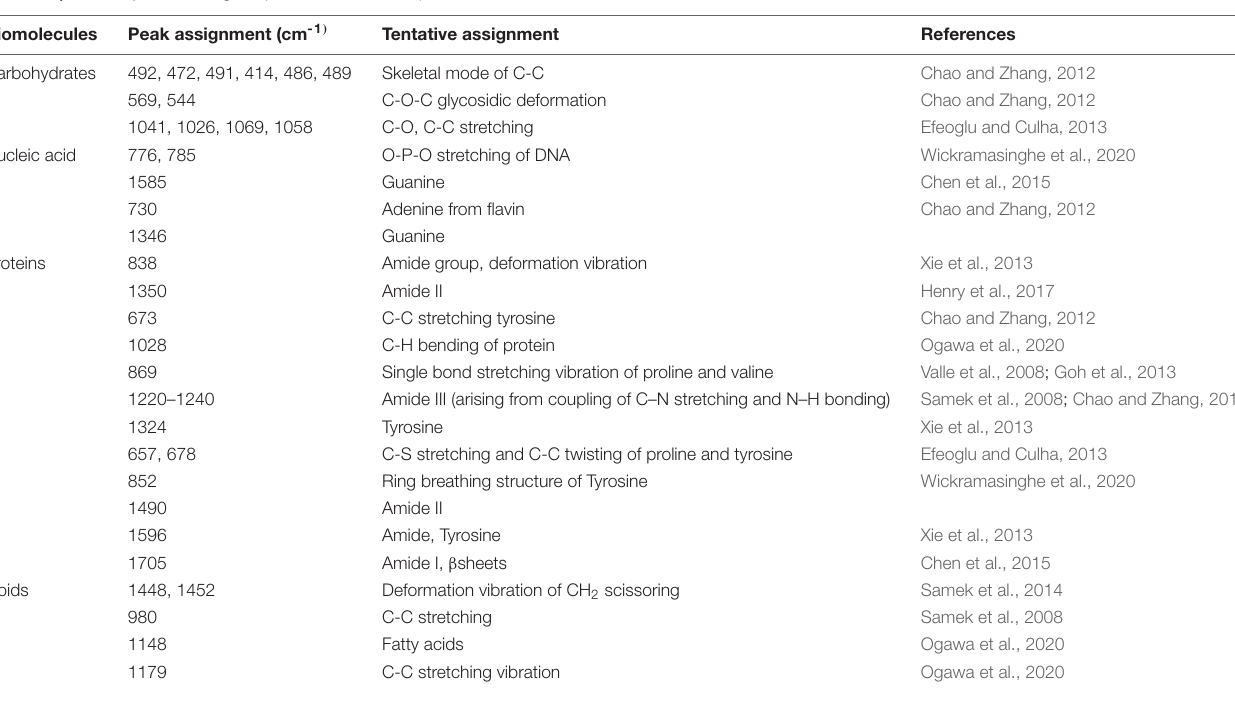
TABLE 1 | Summary of the assigned peaks in the SERS